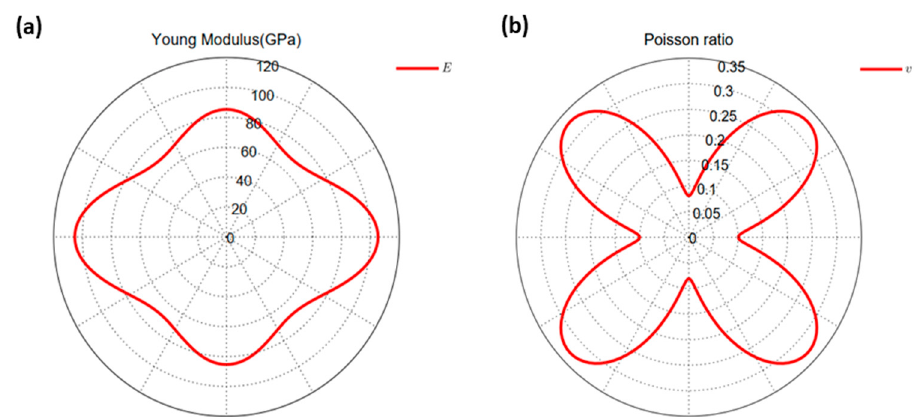
Figure 3. Directional dependences of ( a ) Young’s modulus, E, and ( b ) Poisson’s ratio, υ .